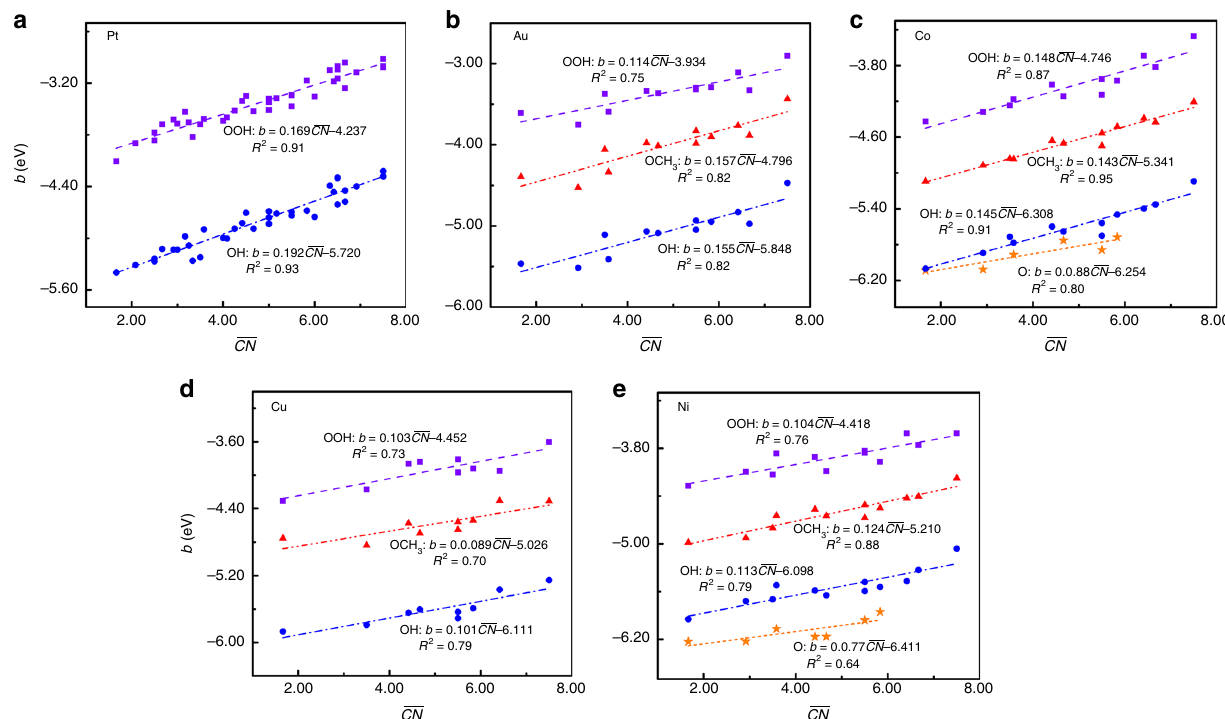
Fig. 3 Structure-offset b relations for species binding via O. a OOH (purple cubes) and OH (blue circles) on thirty-eight different types of Pt surface sites 23 . b – e OOH (purple cubes), OH (blue circles), OCH 3 (red triangles), and O (orange star) on twelve different types of Au ( b ), Co ( c ), Cu ( d ), and Ni ( e ) surface sites 35 , where each adsorbate is generally adsorbed on the same site from one surface to the next. In each panel, the offset b of the ψ -determined scaling relation is linearly correlated with the generalized coordination number CN of surfaces. The details of surface sites are provided in Supplementary Tables 1, 2, and 7, whereas the linear fi ts are provided as insets and the corresponding parameters are summarized in Supplementary Table 9. Clearly, the offset b is linearly scaled with the structure parameter following Eq. (4) in the main text. The prefactor λ of the term is also governed by electron-counting rules and can be described by the saturated-bond number of the central atom in adsorbates. Source data are provided as a Source Data fi